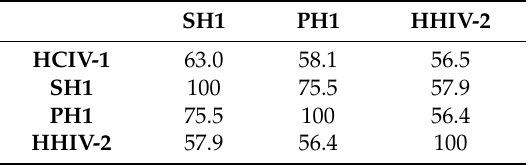
Table 2. Overall nucleotide identities (%) between virus